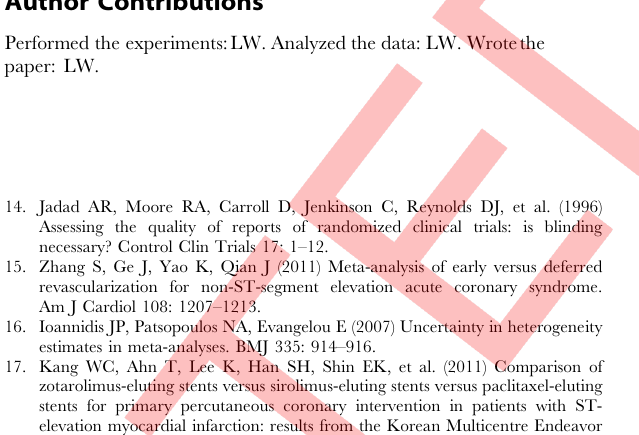
Table S1 Quality assessment of the enrolloed